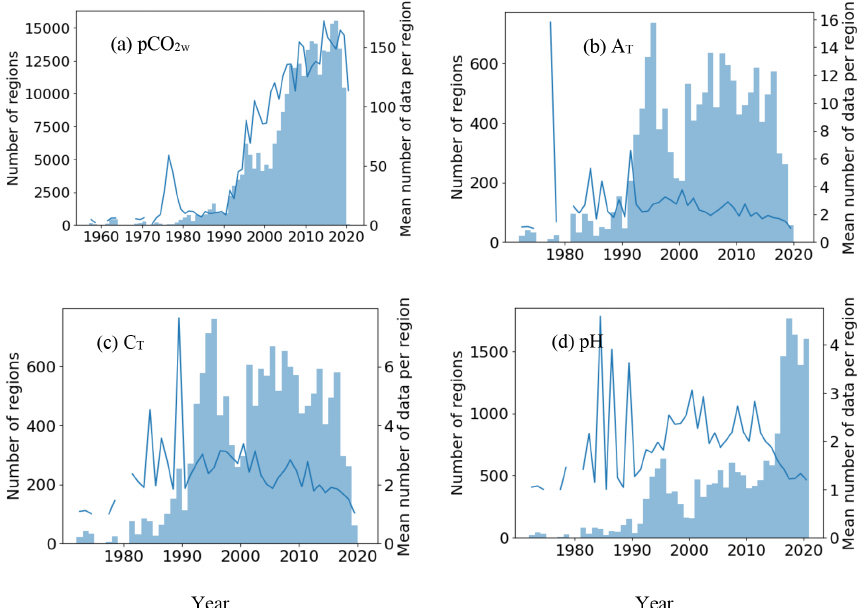
Figure 2. Numbers of ROIs per year (bars) included in the database containing measurements of each carbonate system parameter and the mean number of measurements per ROI (lines), for (a) pCO 2w , (b) total alkalinity ( A T ), (c) dissolved inorganic carbon (C T ) and (d) pH.